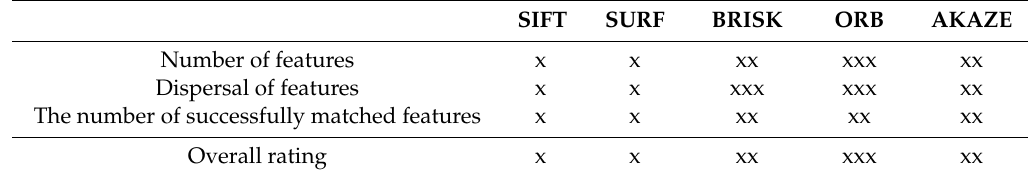
Table 1. The evaluation of detectors test.